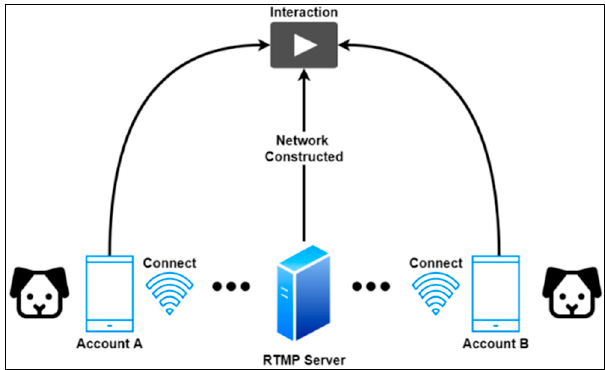
Figure 9. The distributed system architecture of proposed dogs’ social network.